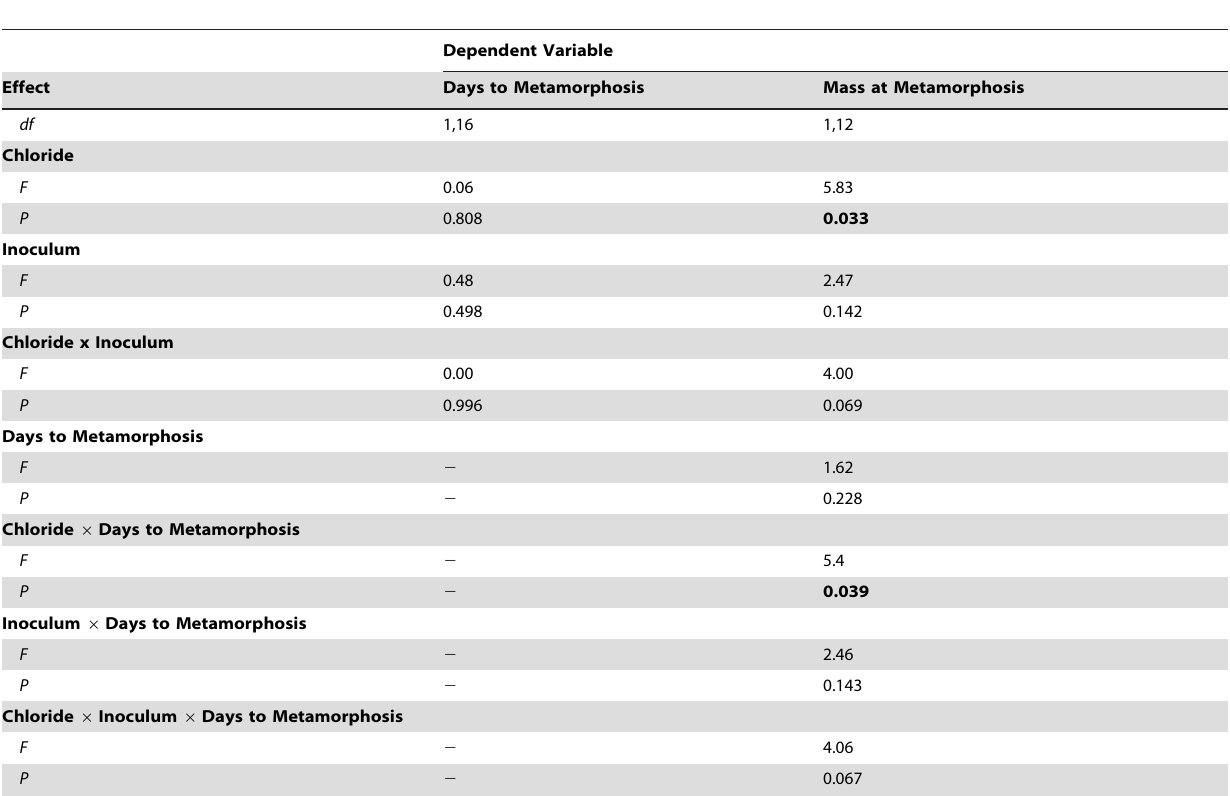
Table 4. Analysis of variance (ANOVA) on mean values of gray treefrog ( Hyla versicolor ) days to metamorphosis and analysis of covariance (ANCOVA) on mean values of mass at metamorphosis with days to metamorphosis as covariate.